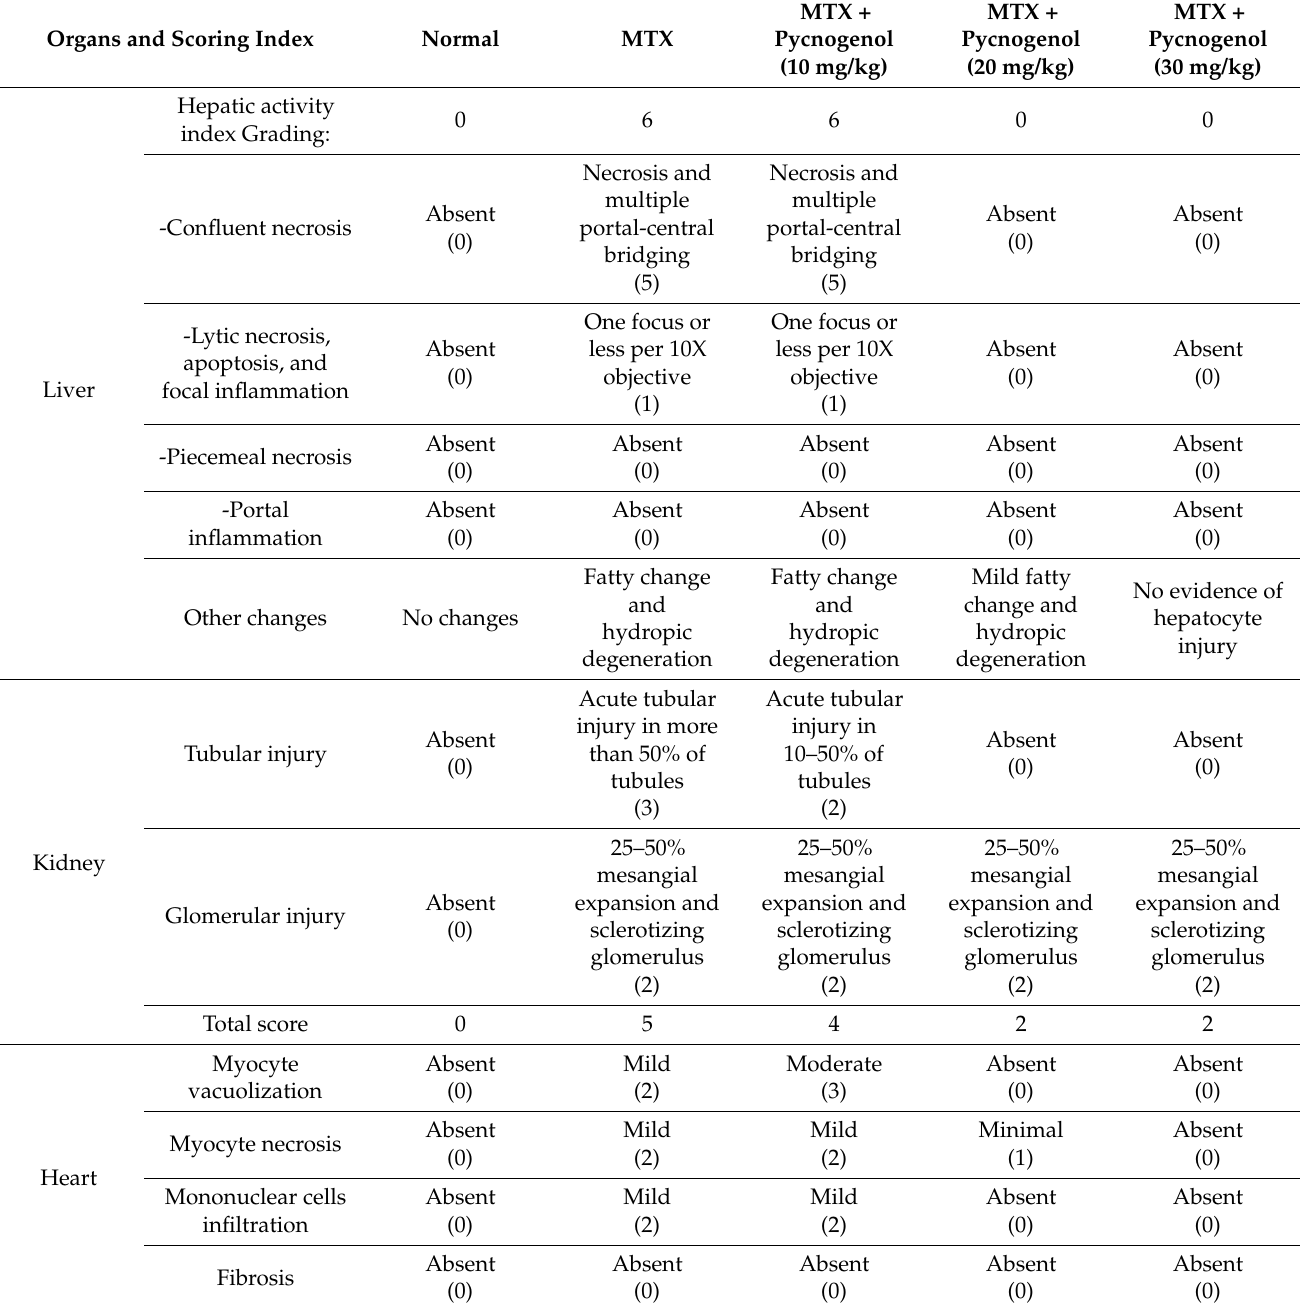
Table 2. Effect of MTX and pycnogenol treatment on histopathological evaluation of liver, kidney, and heart tissue